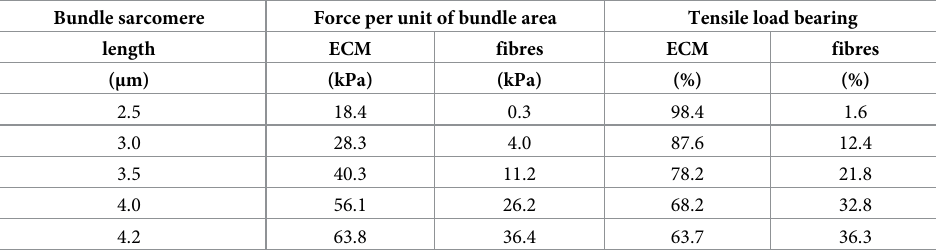
Table 3. Percentage tensile load bearing of ECM and fibres estimated by the fitting of Eq (9) to experimental